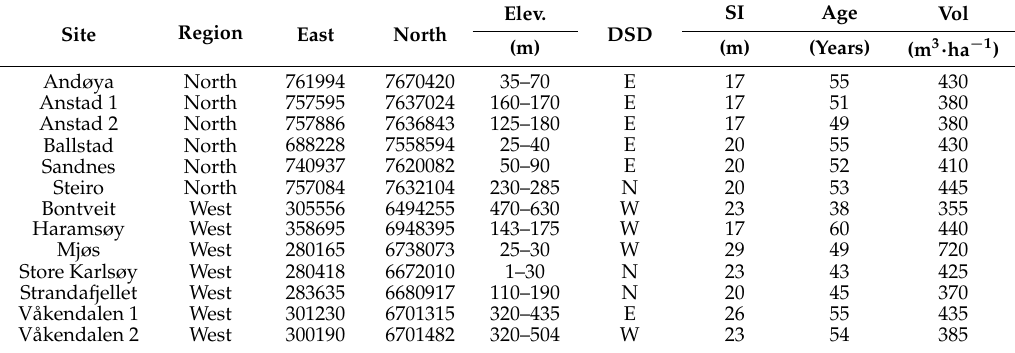
Table 1. Sites included in the study and some characteristics. Region denotes north or west Norway. Elev. = elevation (meter above sea level). DSD = Dominant spread direction; E = east, W = west, N = north. Age = total age of parent stand in years from seed. SI = site index class (H 40 ). Vol = Standing